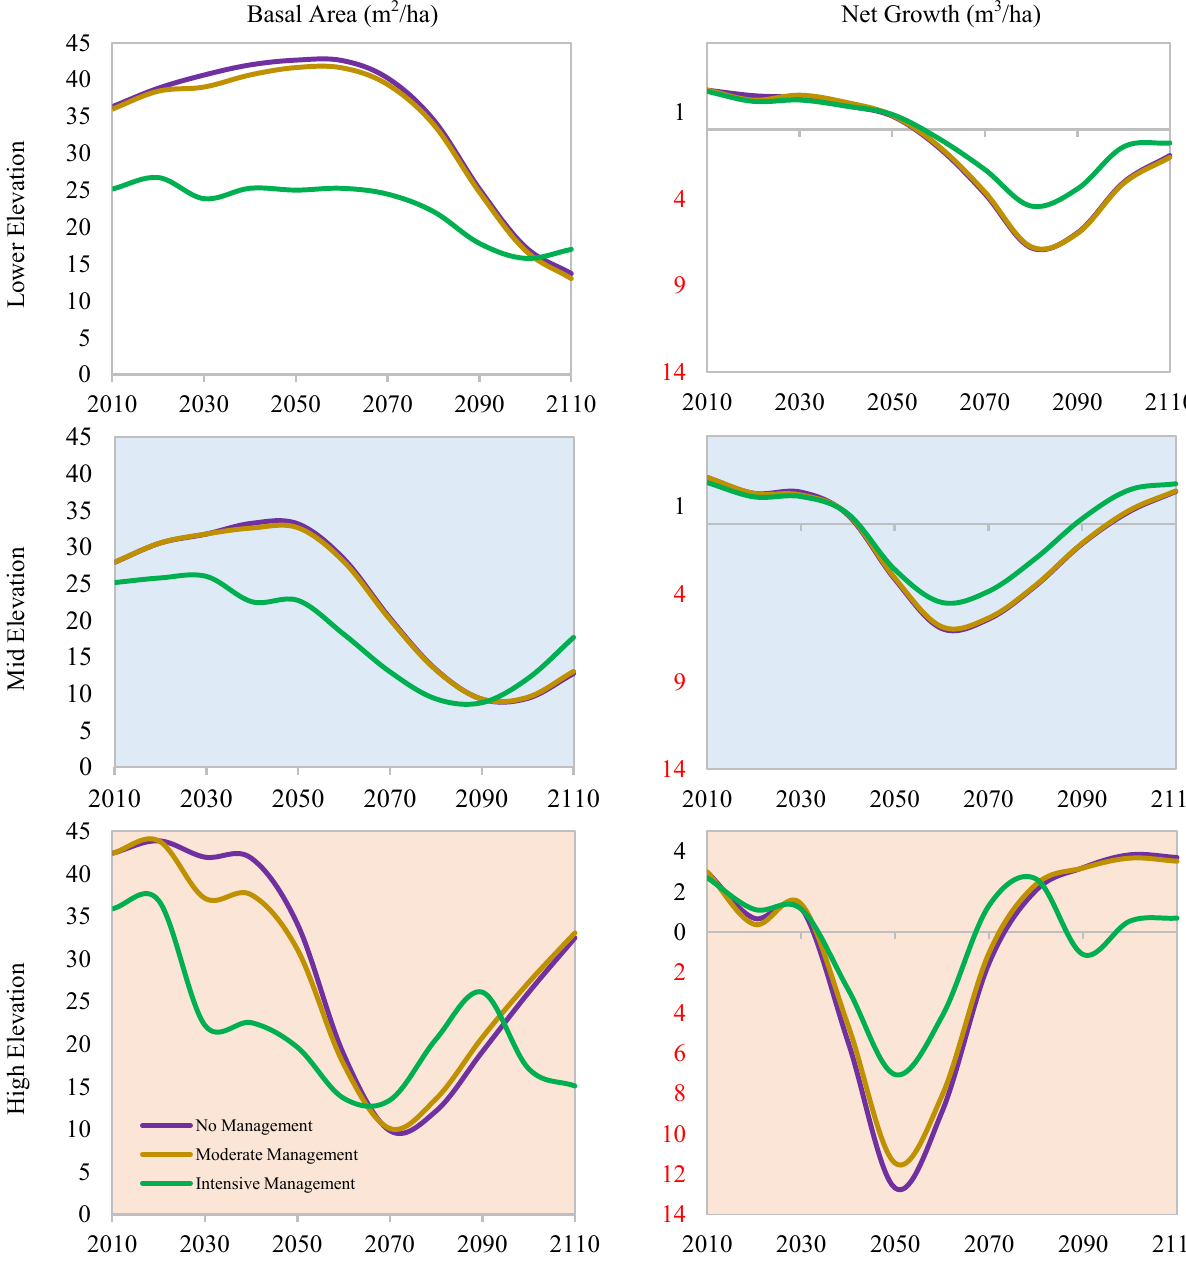
Figure 3. Effect of management on stand resilience for low, mid, and higher elevation ponderosa pine groups under the RCP 6.0 climate change scenario. Management scenarios include a no management (purple), moderate-intensity management (brown), and intensive management (green) described in Section 2.6. Left column compares BA and right column compares net growth for different management intensities. Upper row presents lower-elevation stands, middle row presents mid-elevation stands, and bottom row presents higher-elevation stands. Basal Area (m 2